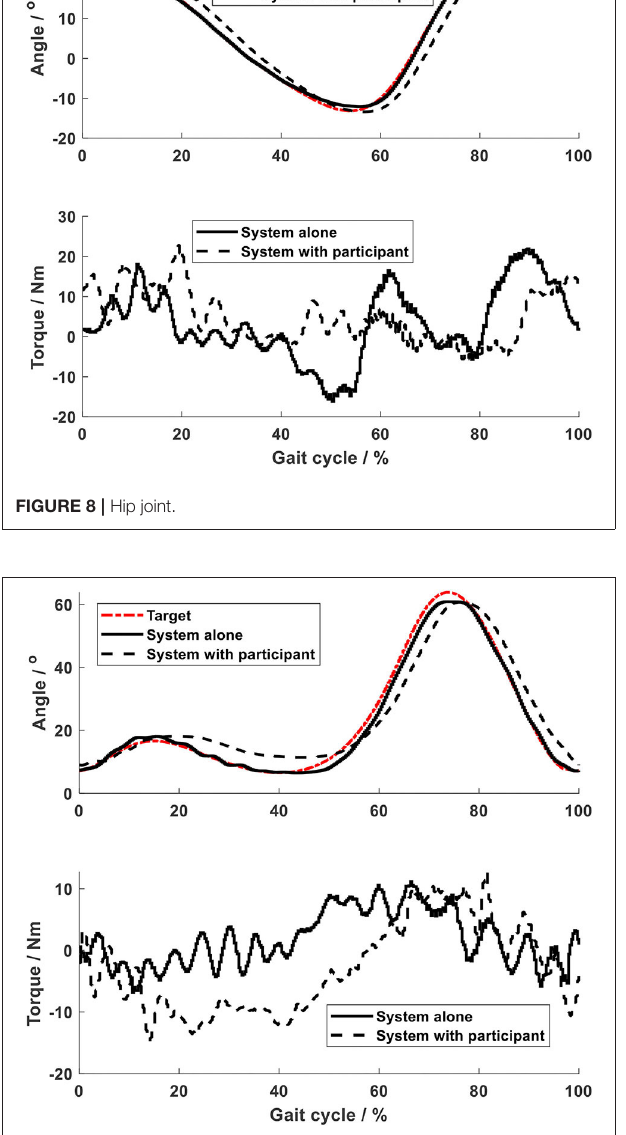
FIGURE 9 | Knee joint.